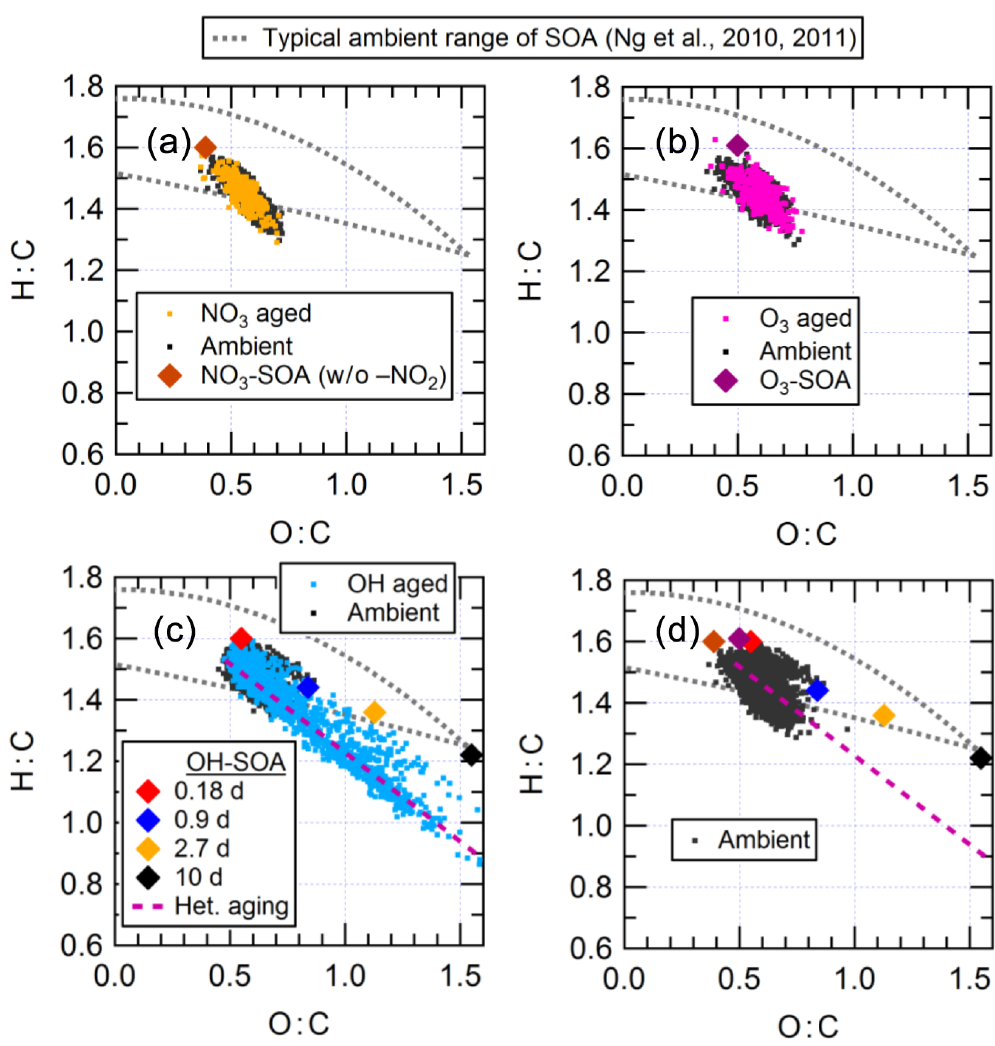
Figure 11. Van Krevelen diagrams of H:C vs. O:C ratios of OA after oxidation by (a) NO 3 , (b) O 3 , and (c) OH along with concurrent ambient ratios. The H:C and O:C ratios of the new SOA mass formed in the OFR (i.e., the slopes from Figs. 8–10) are shown for each oxidant (diamonds) and are summarized in (d) compared with all ambient measurements. For data where no net C addition was observed after OH oxidation, the slope along which heterogeneous OH oxidation transforms the ambient OA is shown (purple dashed